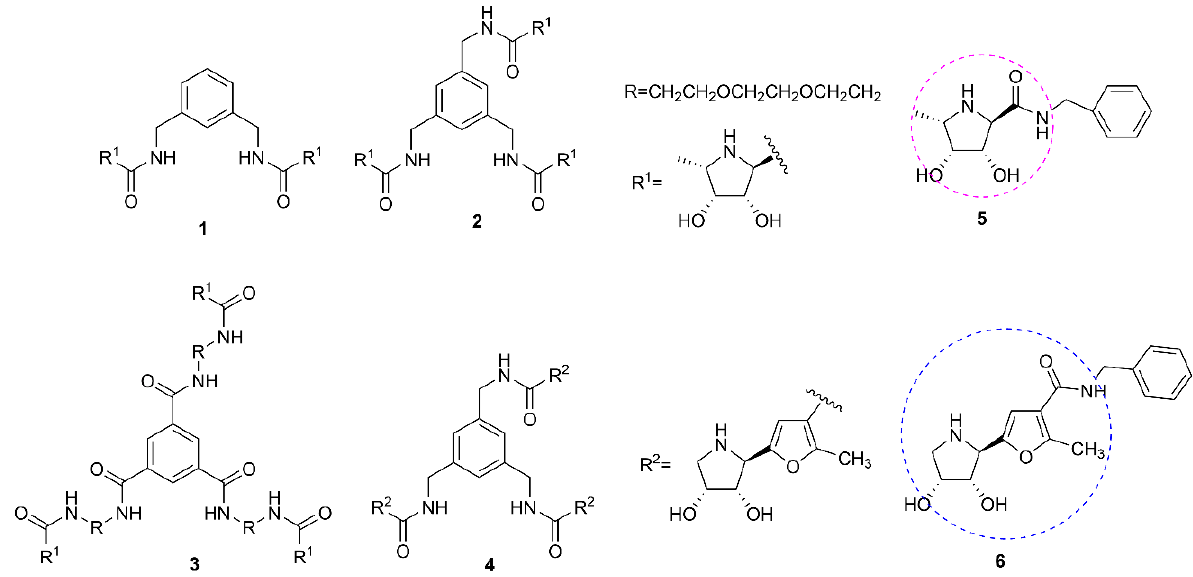
Figure 3 . Structures of multivalent pyrrolidine iminosugars 1 – 4 and monovalent α - L -fucosidase inhibitors 5 and 6 .